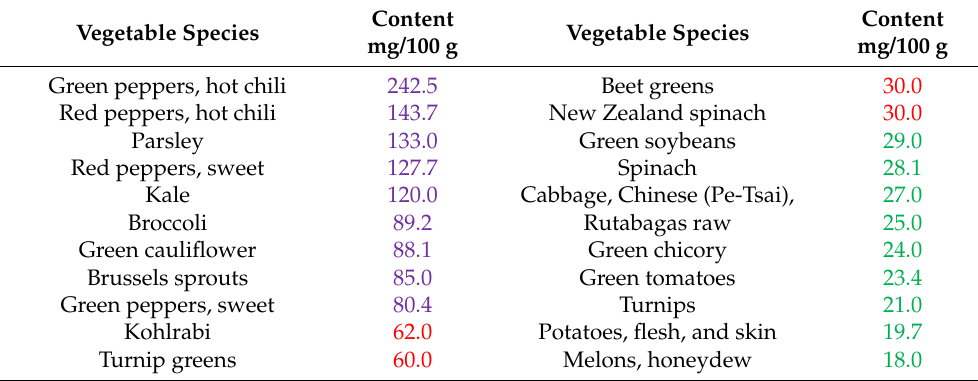
Table 2. L-Ascorbic acid content in fresh vegetables